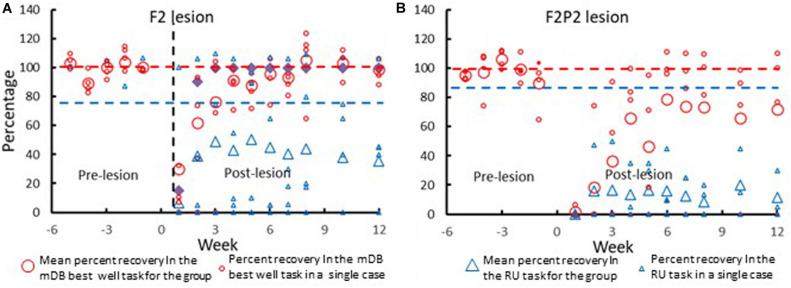
Recovery of contralesional hand performance in the mDB and RU tasks in all F2 (A) and F2P2 (B) lesion cases. The large symbols show mean data across all subjects within the group. The smaller symbols show data from individual monkeys. Recovery of performance in the mDB best well task (red circles) was computed as the percentage ratio of post-lesion performance score/average prelesion performance score (over the last five pre-lesion tests) on the well with highest pre-lesion skill (best well). Recovery of spontaneous use of the contralesional hand in the RU task (blue triangles) is plotted as the %use of that hand in the post-lesion tests. The red dashed horizontal line represents average pre-lesion performance scores over the last five pre-lesion tests. The dashed blue horizontal line represents pre-lesion use of the preferred hand in the test of hand preference. Note that data for the RU task for SDM91 of the F2P2 lesion group was all zeros as this monkey never use the contralesional hand in the RU task. Similarly, SDM91 had very poor recovery in the mDB best well task as there were no attempts made to reach to and grasp the food target (performance score = 0) on most trials.